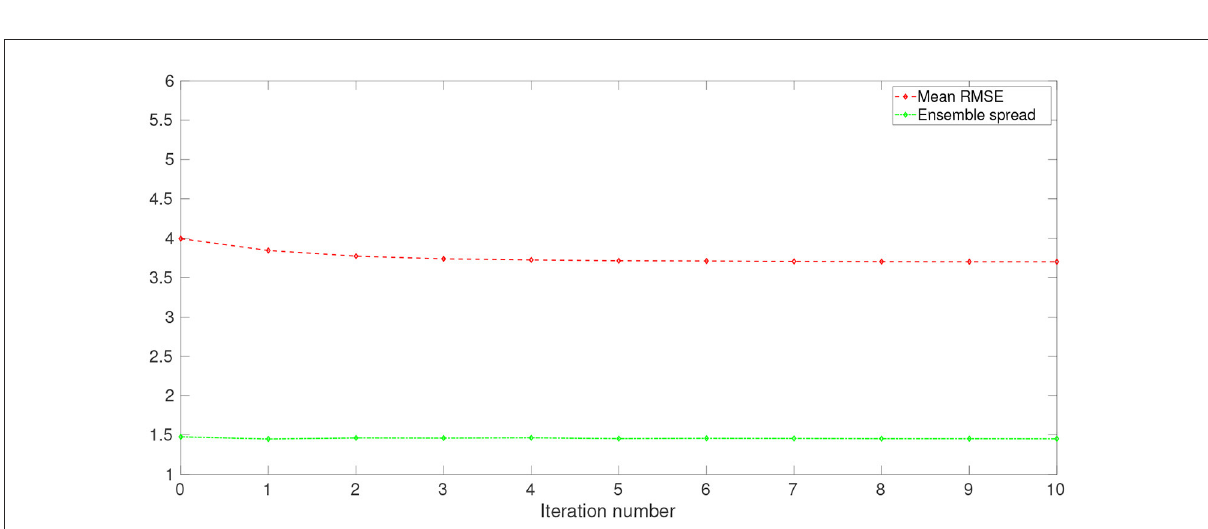
FIGURE7 Mean RMSE (dashed red line) and ensemble spread (dash-dotted green line) vs. iteration step, at one of the data assimilation cycles of the 1,000-dimensional L96